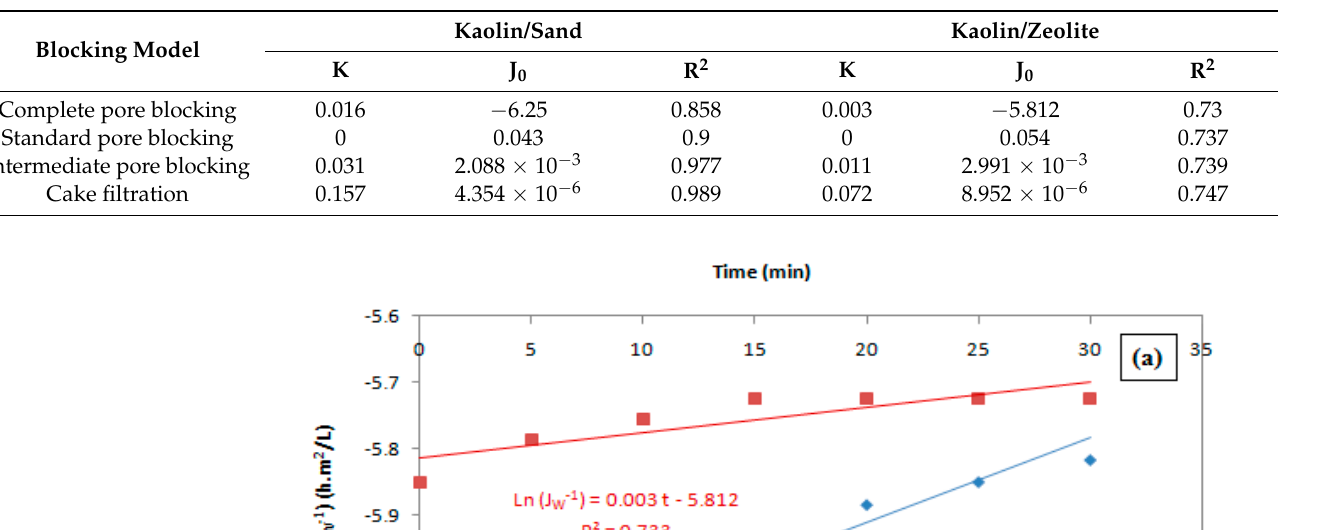
Table 3. Parameters associated with various pore blocking